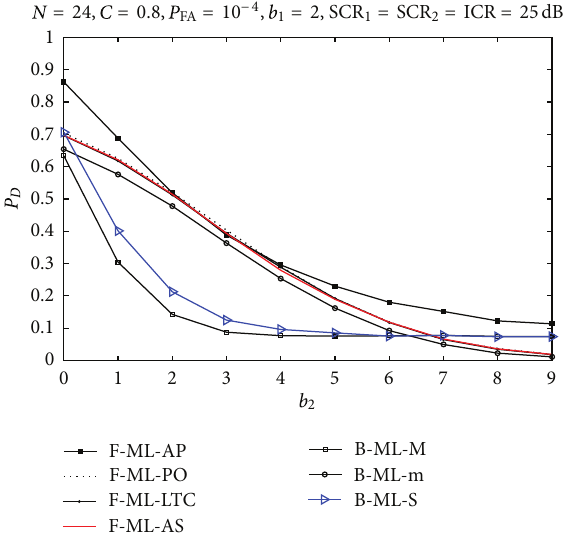
FA performance of detectors based on ML CFAR processorversusnumberofreferencewindowscellsinsensor1�lled with strong clutter when test cell (cut) and reference window cells in 𝑃𝑃 sensor 2 are �lled with strong clutter, , CNR = 10 𝑁𝑁 = 24